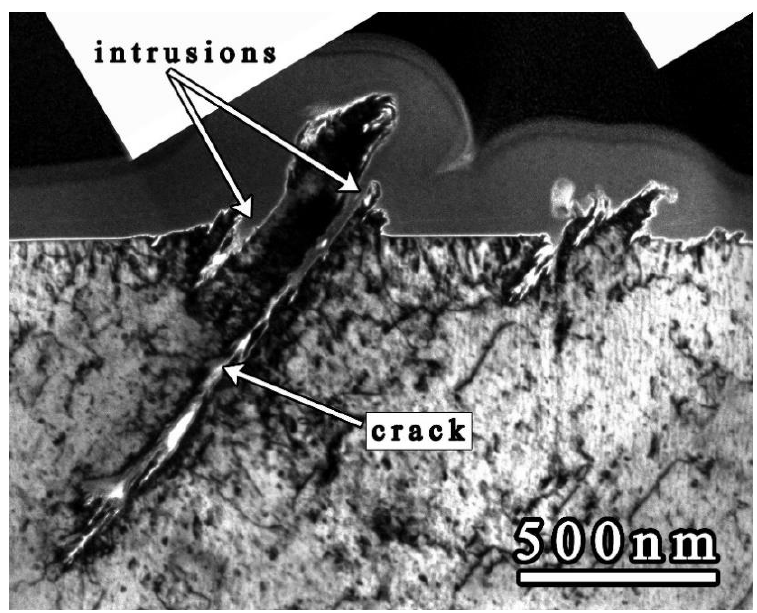
Figure 16. TEM image of the lamella prepared from the surface of fatigued Sanicro 25 steel showing two PSMs with short cracks starting from intrusions.